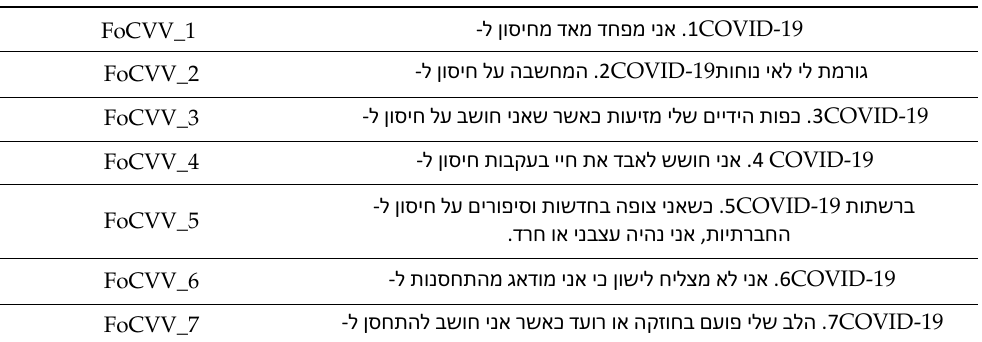
Table A3. Fear of Coronavirus Vaccination Scale (FoCVVS) in the Hebrew language. יפלכ סחי ןוסיחה ל -